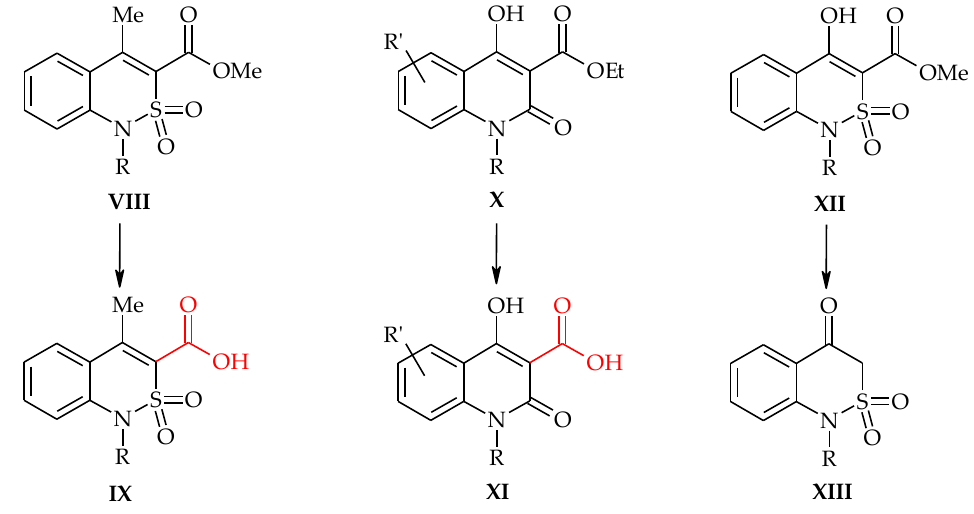
Figure 2. Probable ( IX ) and known ( XI and XIII ) hydrolysis products of esters of 4-hydroxy-2-oxoquinoline- [7] and 4-hydroxy-2,2-dioxo-2,1-benzothiazine- [8] 3-carboxylic acids.